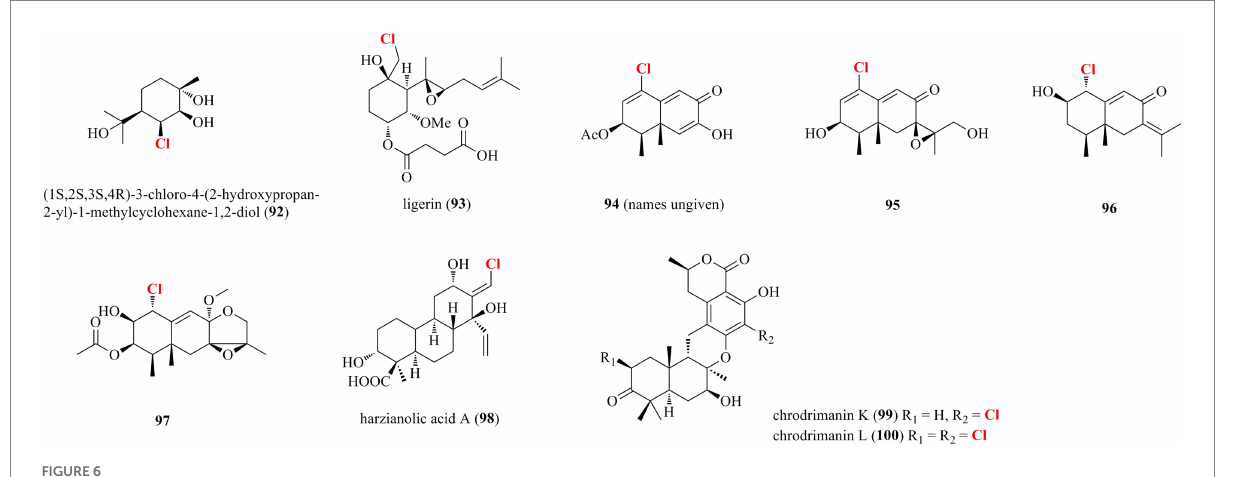
FIGURE 6 Halogenated terpenoids from marine-derived fungi ( 92–100